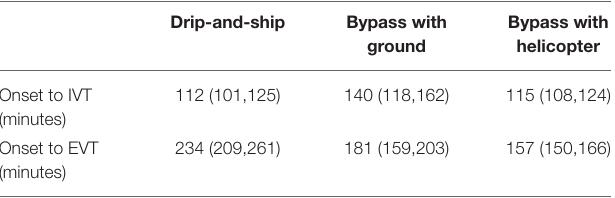
tmaptools (R-package interface to OpenStreetMap Nominatim). TABLE 1 | Onset to treatment for patients in the catchment area of a primary